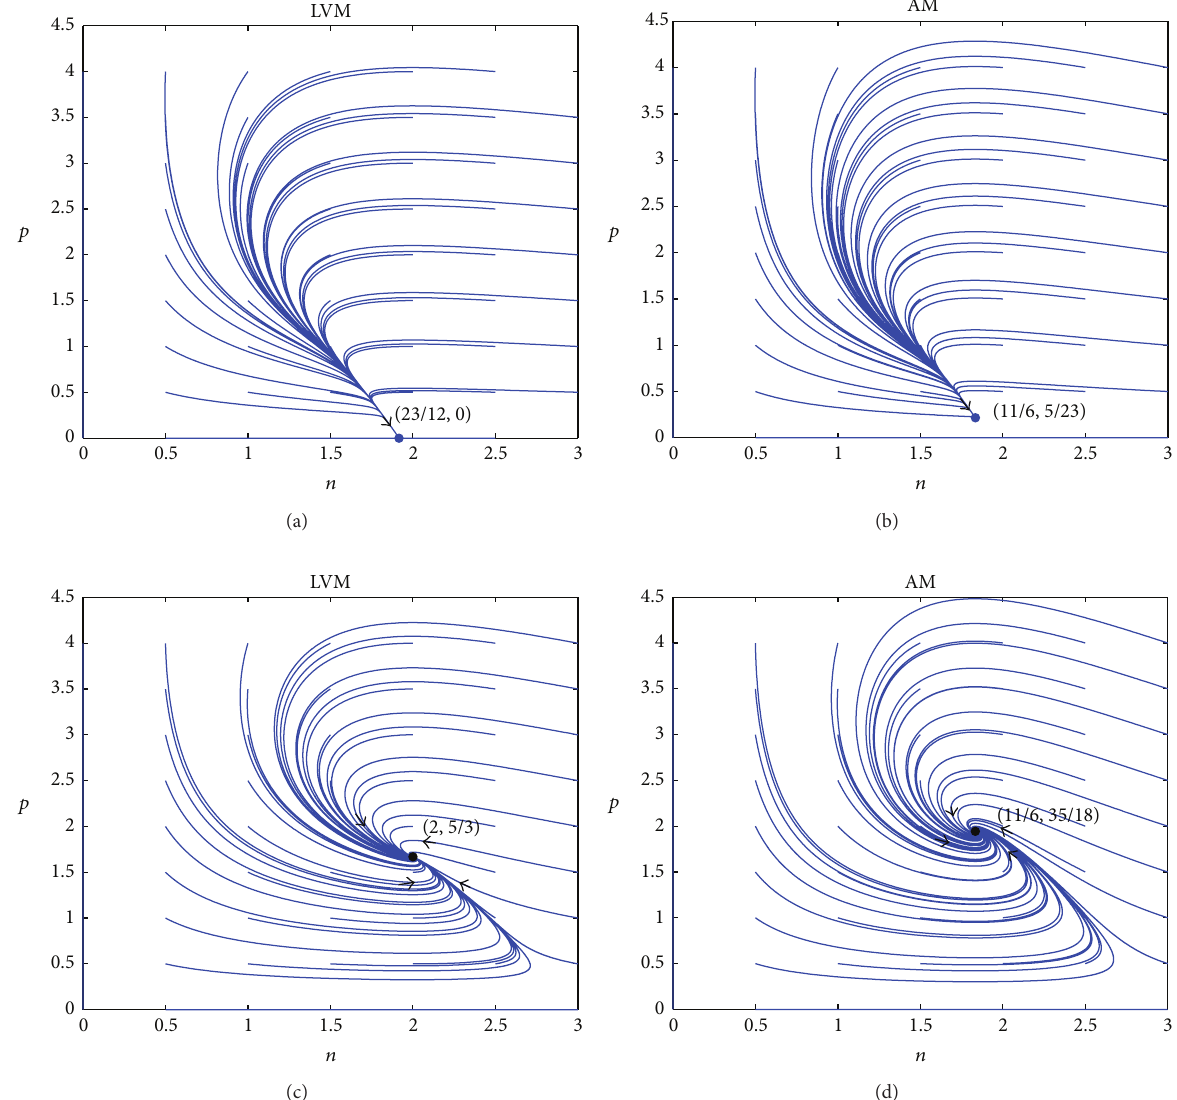
Figure 1: The dynamics of LVM and AM given the condition 𝐶 < 𝑢/𝛼 . Parameters are 𝑟 = 5 , 𝐾 = 23/12 , 𝑎 = 1 , 𝛼 = 1 , 𝐶 = 3/2 , and 𝑢 = 2 in the first two figures, the carrying capacity is set to be 𝐾 = 3 in the other